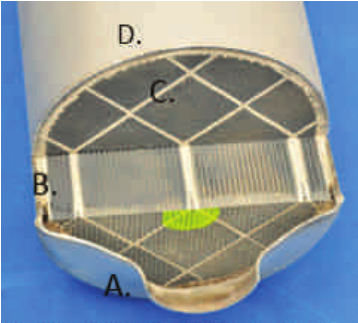
Fig. 4. Cross-section through a catalytic converter: A – cone, B –